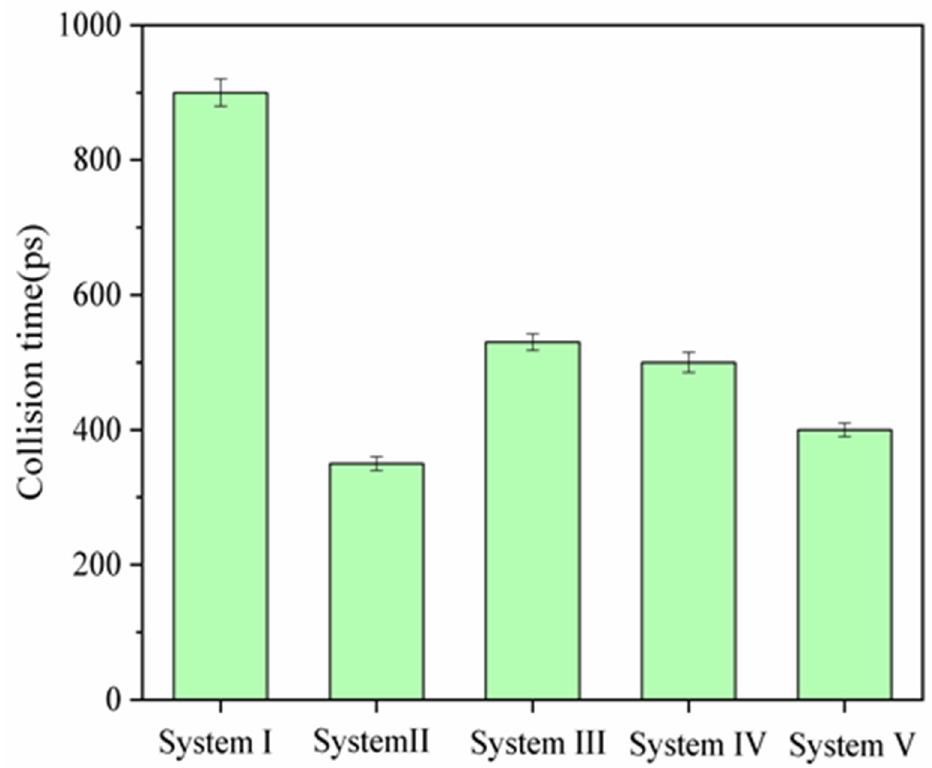
Figure 3. Collision time of oil droplets in five systems under the electric field of 0.5 V/nm.